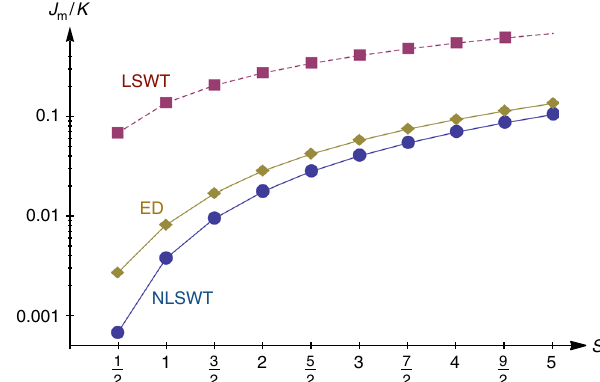
Fig. 3 Evolution of J m as a function of S . The three curves are extracted from linear spin-wave theory (LSWT, red squares), non-linear spin-wave theory (NLSWT, blue circles), and exact diagonalizations (ED, dark